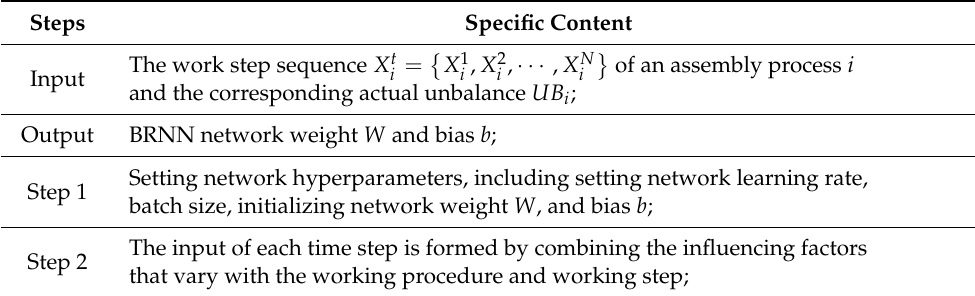
Figure 4. Realization process of unbalance prediction model based on the BRNN network. Table 2. Training steps of unbalance prediction model based on the BRNN network.